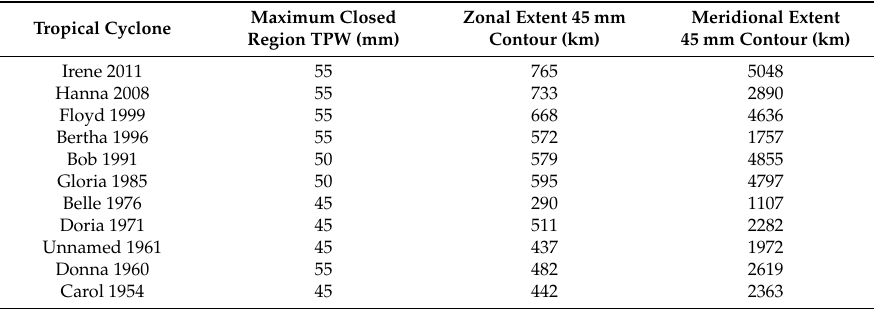
Table 4. Data pertaining to moisture for each